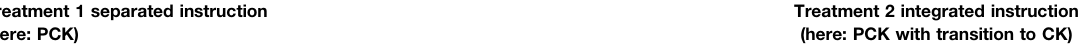
TABLE 3 | Example of how a task was embedded in treatment 1 and treatment 2 and how the corresponding transition was phrased. Treatment 1 separated instruction (here: